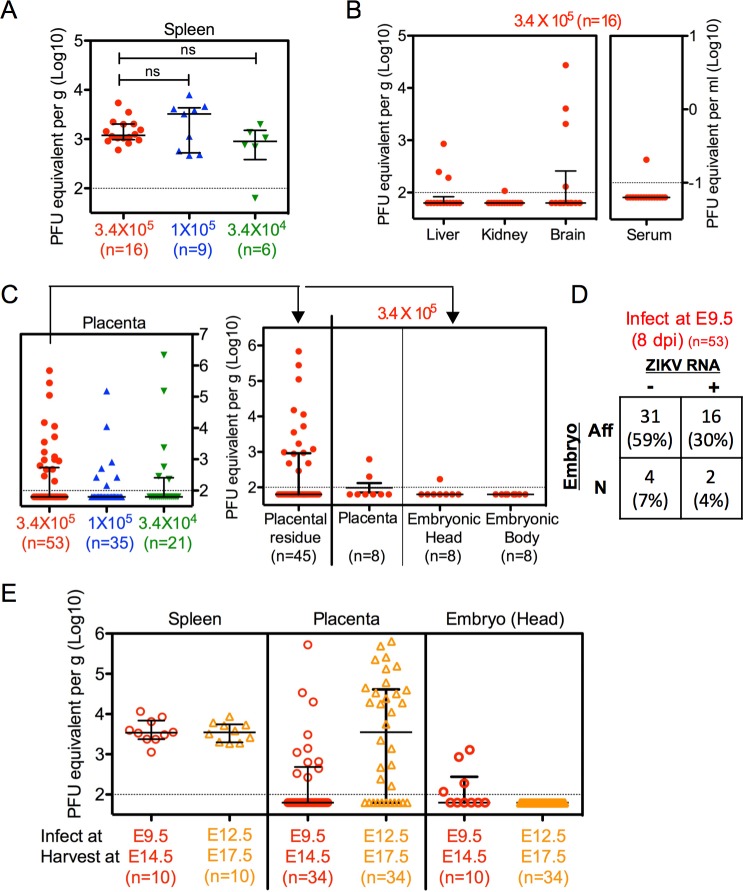
ZIKV RNA is detectible but its presence does not correlate with fetal outcomes.(A-D) Pregnant dams at E9.5 were infected with 3.4, 1, or 0.34 × 105 PFU of ZIKV by intravenous route, and sacrificed 8 dpi at E17.5. ZIKV RNA levels were measured by quantitative real-time PCR. (A) ZIKV RNA levels in the spleens of dams infected with 3 doses of ZIKV. (B) ZIKV RNA levels in the liver, kidney, brain or serum in dams infected with 3.4 × 105 PFU. (C) ZIKV RNA levels of all placental samples carried by dams infected with 3 doses (left panel), or placental residues or remaining intact embryos and their corresponding placentas carried by dams infected with 3.4 × 105 PFU (right panel). (D) Summary of embryonic outcome in relation to viral RNA presence. The table depicts the numbers and percentages of embryos that were affected (Aff) or normal (N) in the absence (-) or presence (+) of detectable ZIKV RNA by real-time PCR in placentas, corresponding embryos, or both. Affected embryos include those which suffered demise/resorption, or exhibited any sign of growth restriction, malformation, or anatomical developmental defect by gross morphological examination. Chi-square test revealed no statistically significant association between viral RNA presence and embryonic outcome (p = 0.97). (E) Pregnant dams were infected with 3.4 × 105 PFU of ZIKV at E9.5 or E12.5, and sacrificed 5 dpi at E14.5 or E17.5, respectively. ZIKV RNA levels in the maternal spleen, placenta or embryonic head were measured by quantitative real-time PCR. (A-C and E) Data shown are median with interquartile range. Dotted line depicts the limit of detection. (ns, not significant by Mann-Whitney test). Number of samples in each group is listed in the parentheses. Data for all panels are pooled from 2–5 independent experiments.